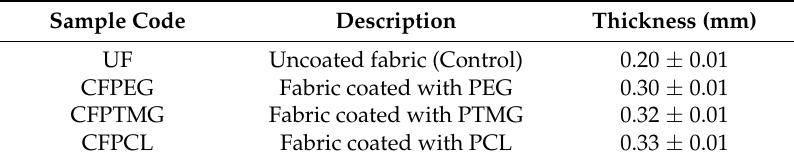
Table 2. Coding and thickness of uncoated and different coated